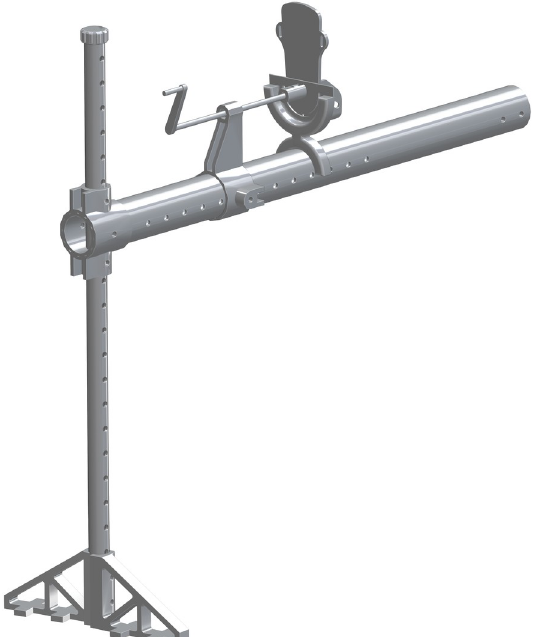
elements with a linear shape function-second order accuracy have been assigned to the objects, and no distorted elements have been reported by the software. As well, the size of elements (seeding and meshing) were decreased so that no difference on the output was observed.